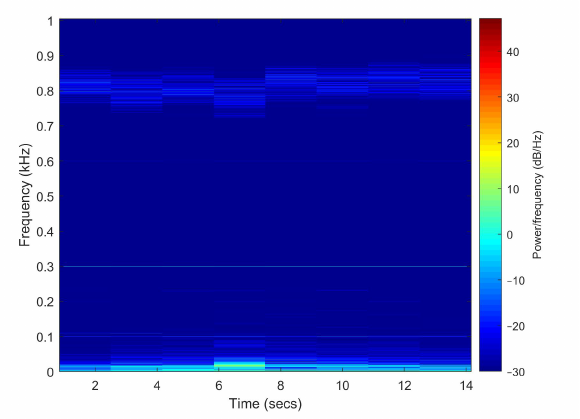
Figure 9. Spectrogram plot of I p for arc event